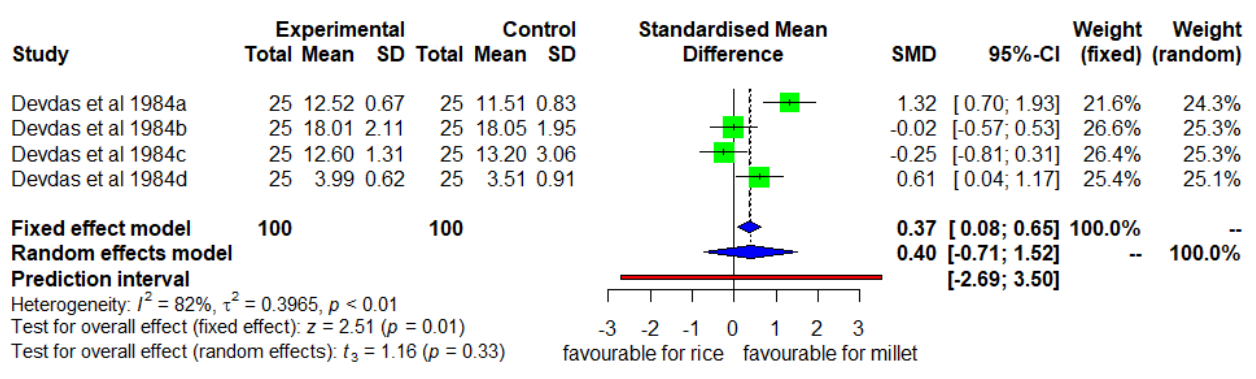
Figure 8. Effect of consuming an enhanced diverse millet-based diet on mean MUAC change compared to an enhanced diverse rice-based diet.